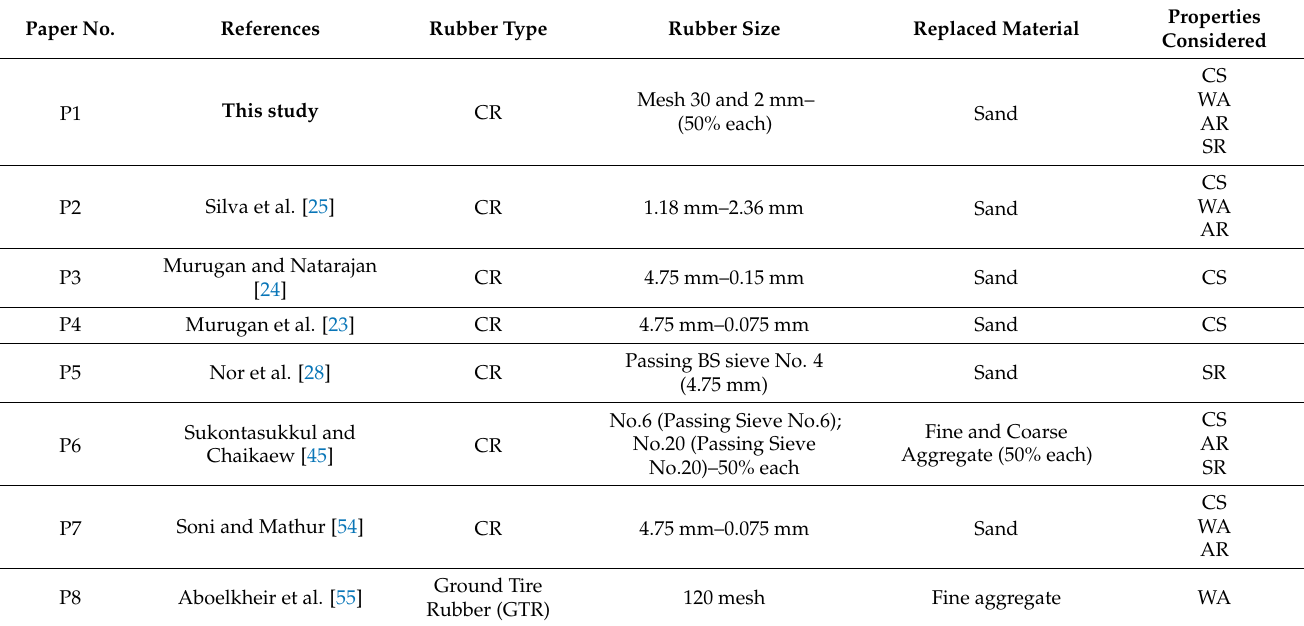
Table 8. Each Study Considered for the Property